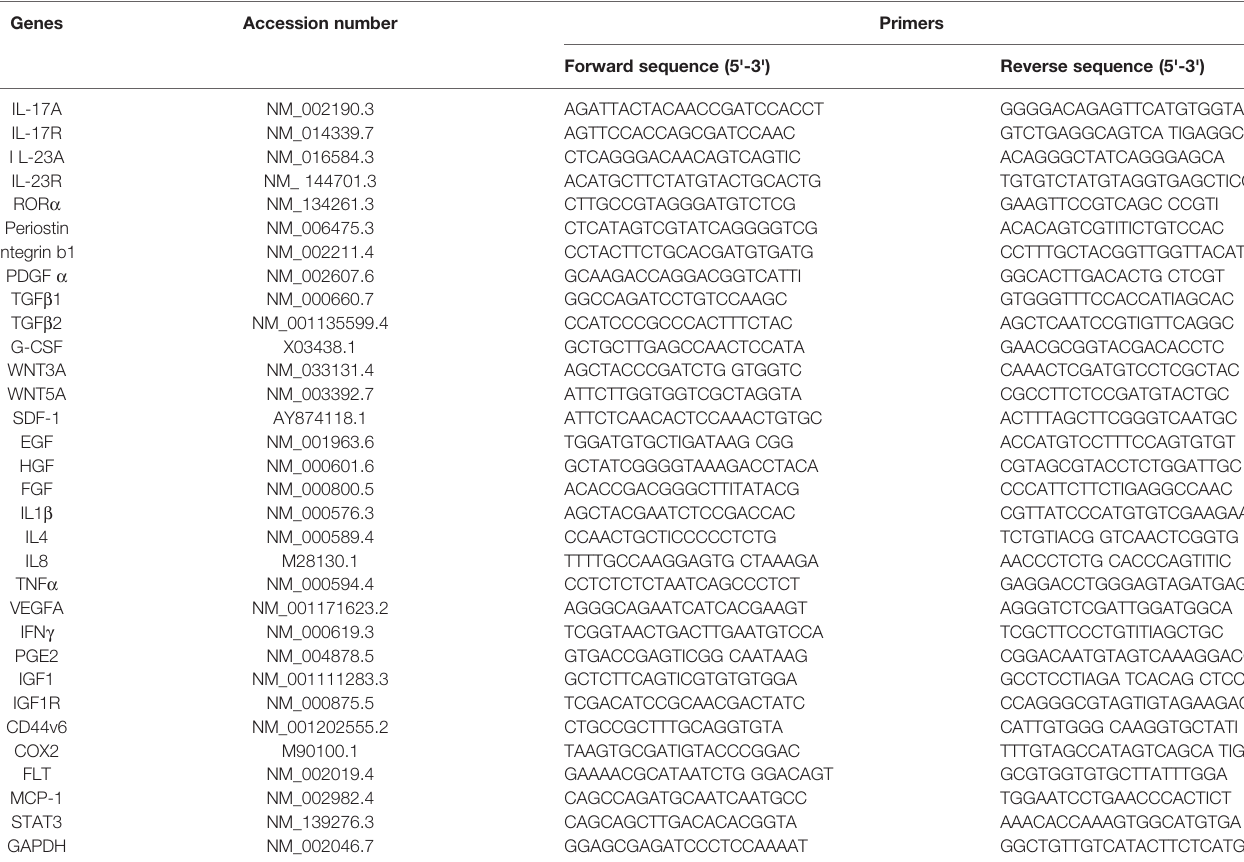
TABLE 3 | Semiquantitative RT-PCR primers for Cytokines, growth factors, PN and relates receptors.